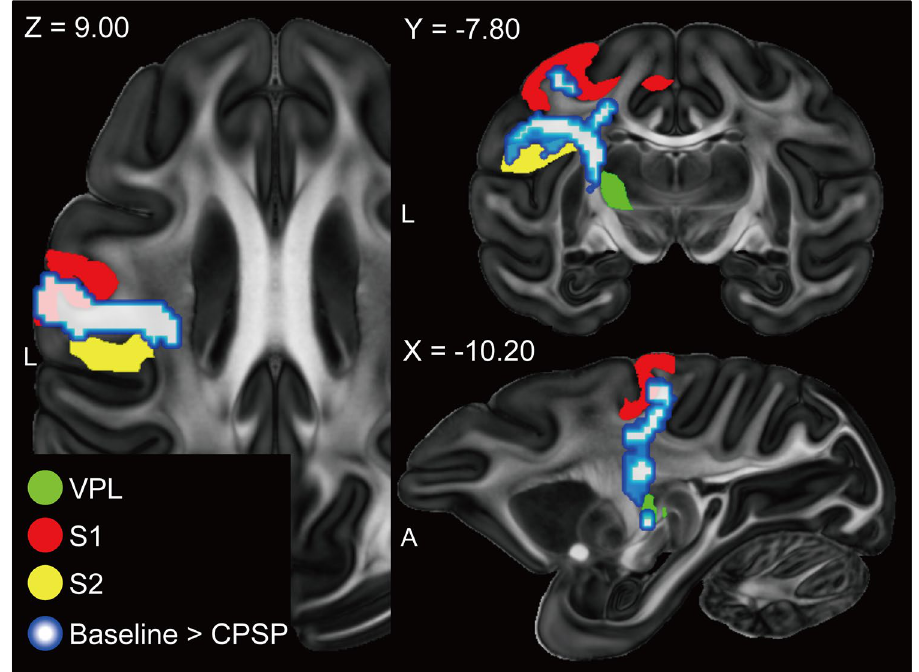
Figure 3. Changes in structural connectivity after CPSP development overlaid on the fractional anisotropy image of the DTI-based atlas. For tractography, the lesion side of the entire thalamus was selected as the seed. The axial (left), coronal (upper right), and sagittal (lower right) slices are shown. The xyz coordinate is defined at the anterior commissure. The blue areas indicate that the structural connectivity was decreased after the lesion (uncorrected p < 0.001 and cluster-size adjusted p -FDR < 0.05). The red, yellow and green areas are S1, S2 and VPL, respectively, marked from the template atlas. A anterior, CPSP central poststroke pain, FDR false discovery rate, L left, S1 primary somatosensory cortex, S2 secondary somatosensory cortex, VPL ventral posterolateral nucleus in the